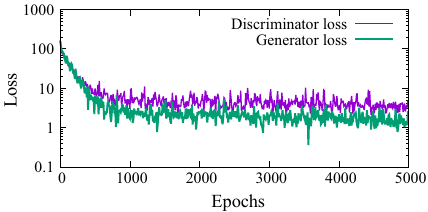
Fig. 4 Loss of the LSGAN discriminator and generator throughout the training